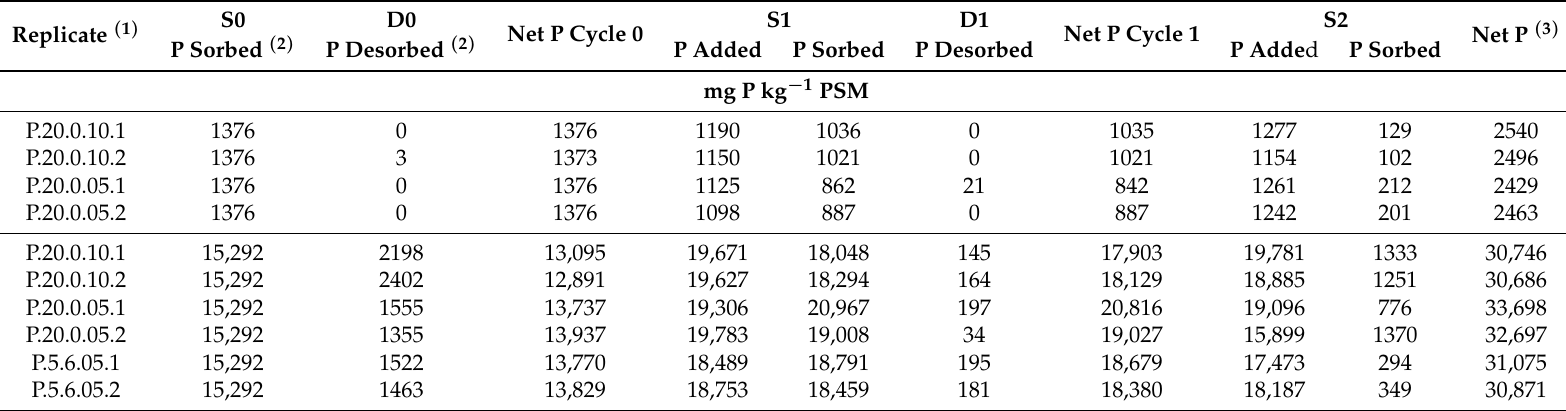
Table A3. PhosRedeem phosphorus (P) sorption and desorption results. Each row represents one regeneration treatment. The first four rows refer to 0.5 mg L − 1 P, the following six are 50 mg L − 1 P